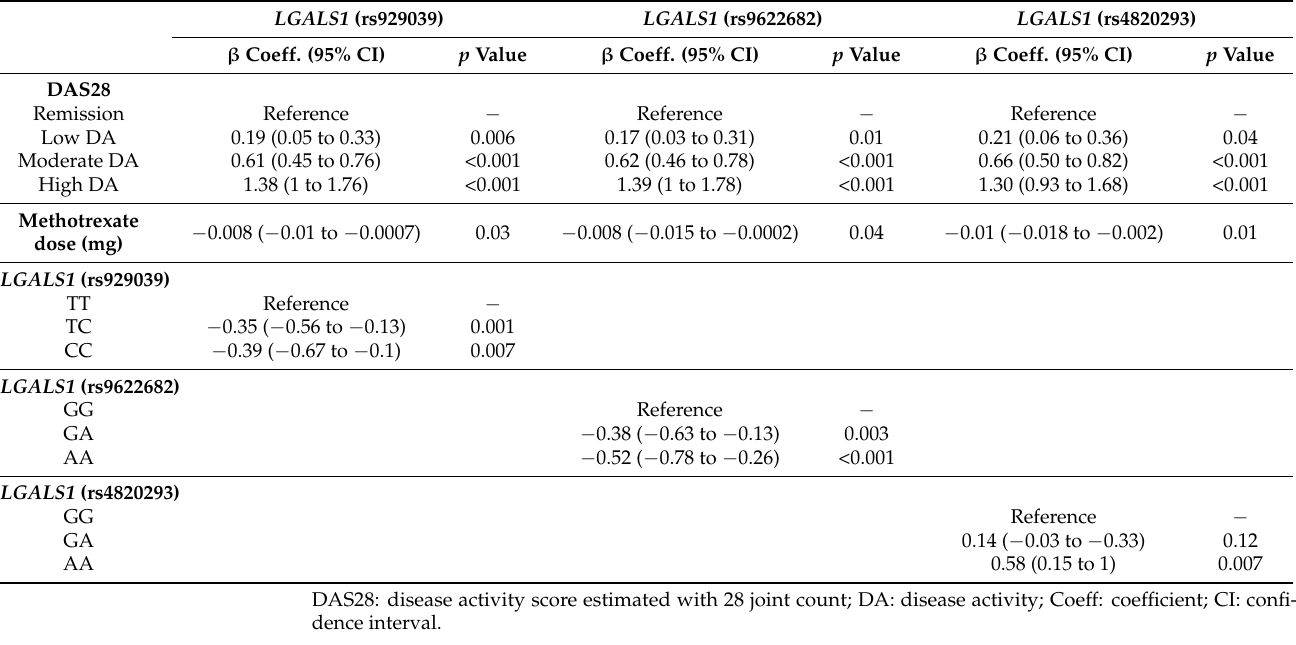
Table 1. Relationship between IL-6 (pg/mL) serum levels and LGALS1 genetic variants.